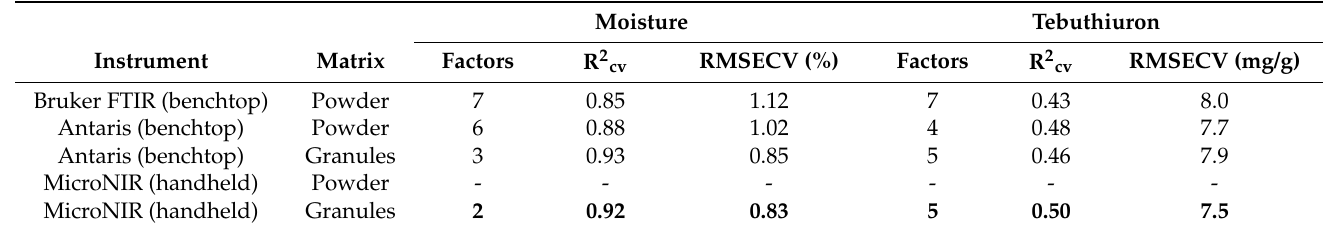
Table 10. Optimum pre-processing methods for the prediction of moisture and tebuthiuron content in powdered and granular Regain samples, using three different IR instruments. The best-performing model for each analyte is highlighted in bold.